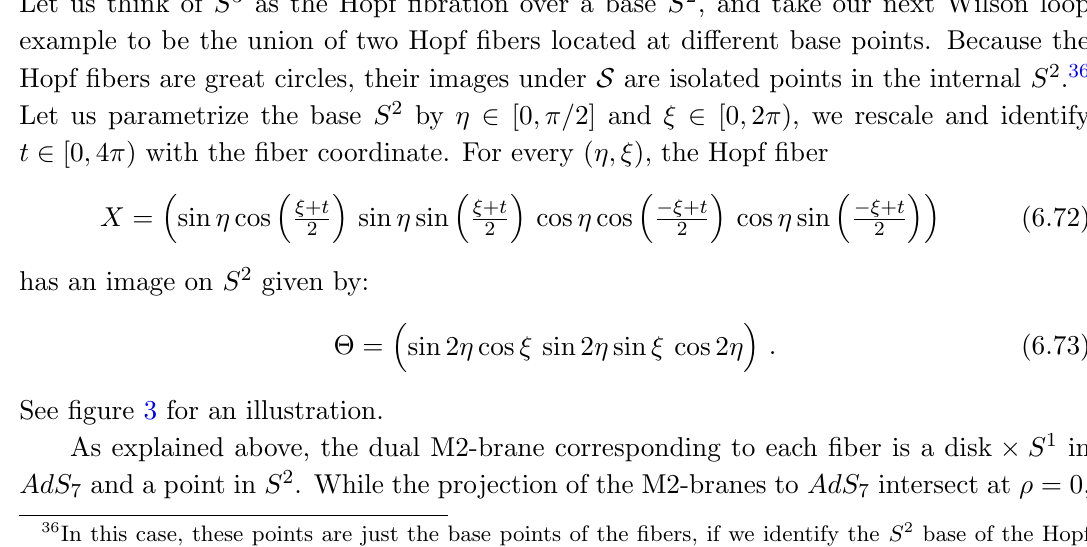
Figure 3. On the left, we plot a pair of Wilson loops in the negative Hopf link configuration on S 3 (after stereographic projection). On the right, the two unknots mapped to two points on S 2 We interpolate in coloring from light to dark as we go around the loop in both figures. The colors are coordinated between the two